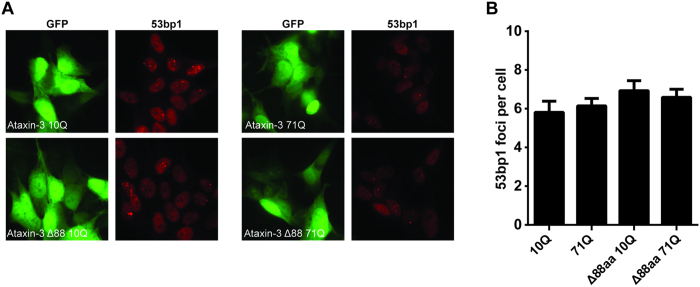
Expanded and modified ataxin-3 do not induce DNA strand breaks in neuroblasts.(A) SH-SY-5Y neuroblast cells transfected with GFP-ataxin-3 constructs were stained for the DNA double strand break marker 53BP1. (B) Quantification of 53BP1 foci in cells from A (>50 cells per condition), mean and SE depicted.